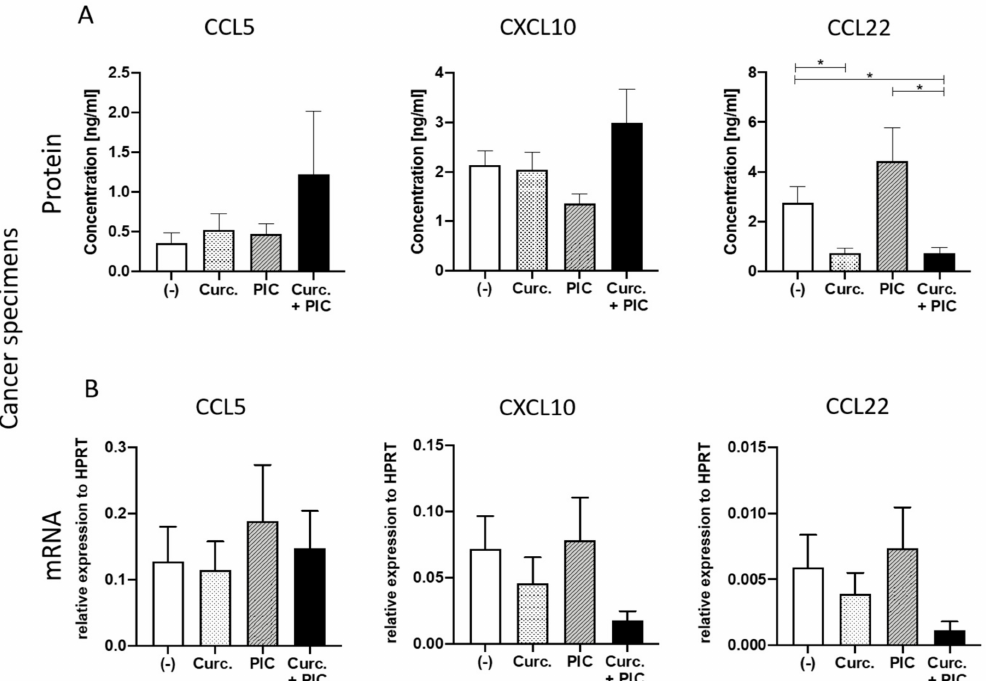
Figure 3. Chemokine expression in ex vivo tumor tissues. ( A ) Detection of chemokines CCL5, CXCL10, and CCL22 in supernatants of cancer specimens after incubation with the negative control (-), 10 µ g/mL curcumin (Curc.) and/or PIC for 24 h. Results were determined via ELISA. n = 5. ( B ) Evaluation of chemokine expression (CCL5/CXCL10/CCL22 in cancer specimens by qRT-PCR after incubation with the negative control (-), curcumin (Curc.) and/or PIC for 24 h. mRNA levels are shown as relative expression to the normalization control HPRT. n = 9. Bars represent mean with standard error of mean (SEM). P- values were determined with the Mann–Whitney test, with * p < 0.05.